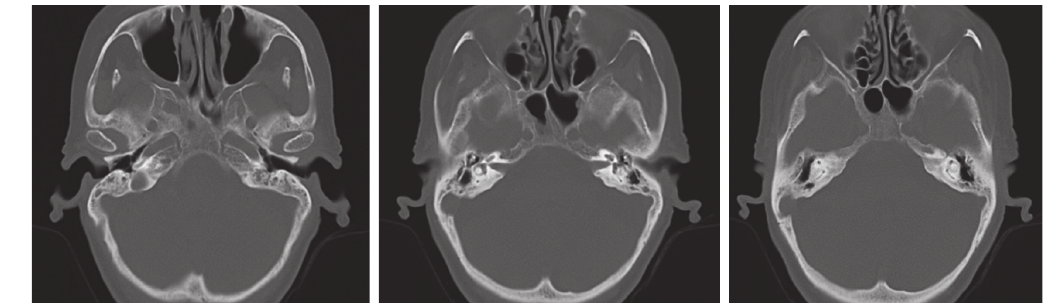
Figure 3: Sequential axial CT layers showing sclerotic mastoid air cells and aerated middle ears bilaterally with no evidence of effusion.